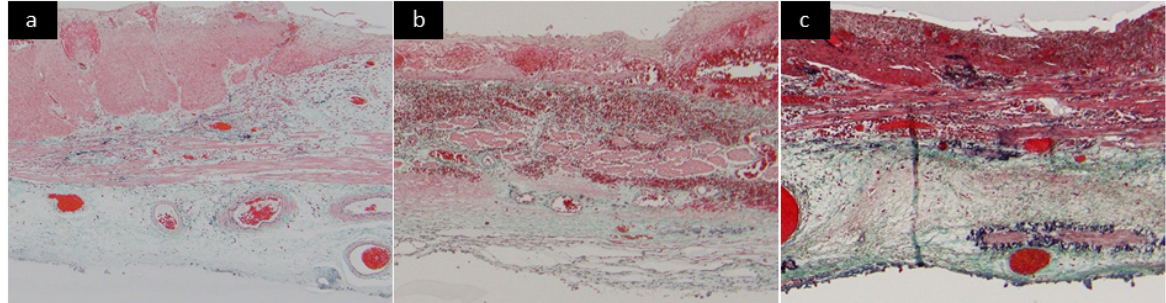
Figure 2. Evaluation criteria for pathological F score. ( a ) None or mild fibrosis (pF0). Fibrosis was defined as mild when fibrous tissue was <20%. ( b ) Moderate fibrosis (pF1). Fibrosis was defined as moderate when fibrous tissue was between 20% and 60%. ( c ) Severe fibrosis (pF2). Fibrosis was defined as severe when fibrous tissue was 60% or